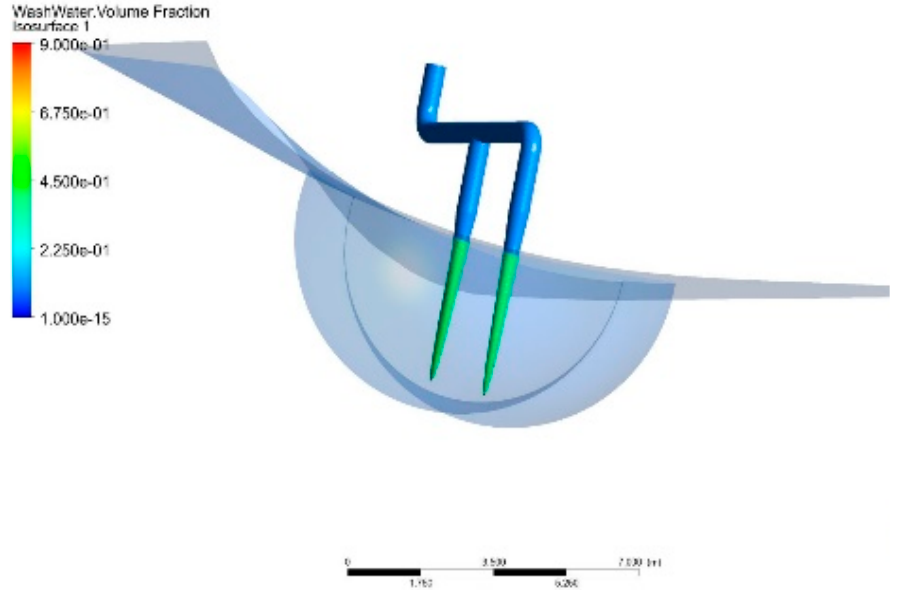
Figure 19. Scrubber Wash Water Volume Fraction of 0.42 isosurface development.